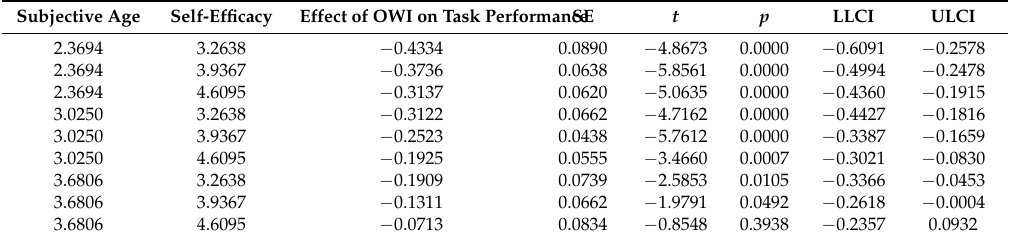
Table 2. Conditional effect of OWI on Task Performance at values of Subjective Age and Self-Efficacy. Subjective Age Self-Efficacy Effect of OWI on Task PerformanceSE